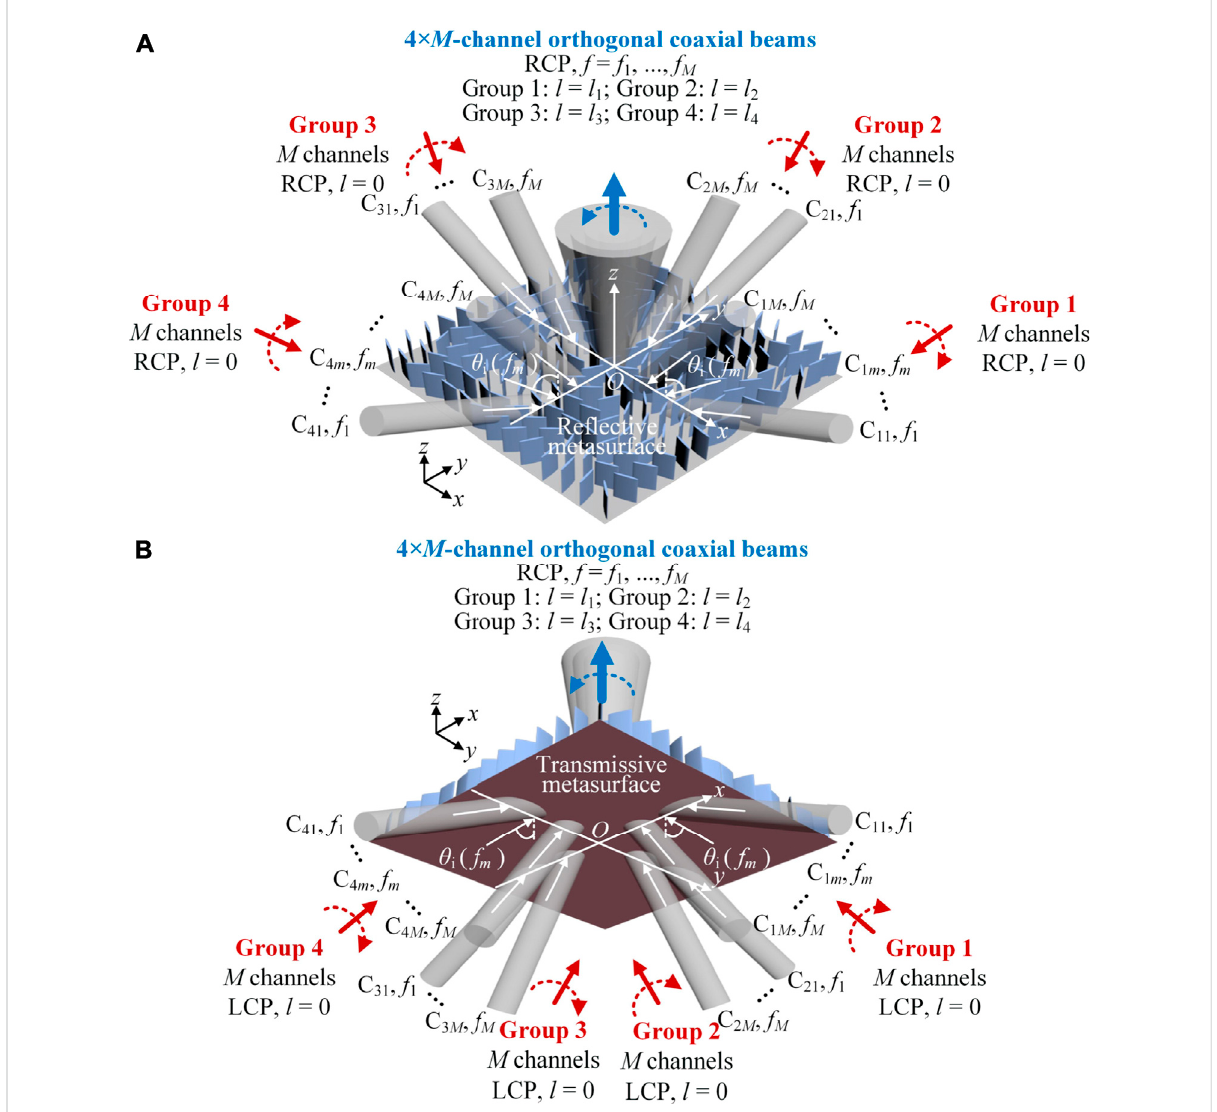
FIGURE 1 The schematic diagram for two-dimensional multichannel multiplexing combing with spatial and frequency domains is achieved by the recon fi gurable dielectric metasurface which can work in both re fl ection and transmission modes (A) For re fl ective metasurface, 4× M -channel off- axis RCP plane waves with the frequency f m and angle of incidence θ i ( f m ) ( m = 1, ... , M ) are incident on the metasurface from the negative z- axis along negative x and y directions, and positive x and y directions respectively, RCP re fl ected waves are transformed into 4× M -channel orthogonal on-axis OAM beams with different topological charges ( l = l 1 , l 2 , l 3 , and l 4 ) or frequencies ( f = f 1 to f M ) (B) Similarly, for the transmissive metasurface, 4× M -channeloff-axis LCPplanewavesareincidentonthetransmissive metasurfacefromthepositive z -axisalongwithnegative x and y directions, and positive x and y directions respectively, RCP transmitted waves are transformedinto 4× M -channel orthogonal on-axis OAM beams with topological or frequency